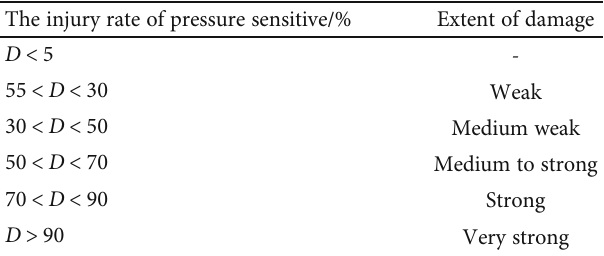
Table 4: The evaluation standard of stress sensitivity. The injury rate of pressure sensitive/% Extent of